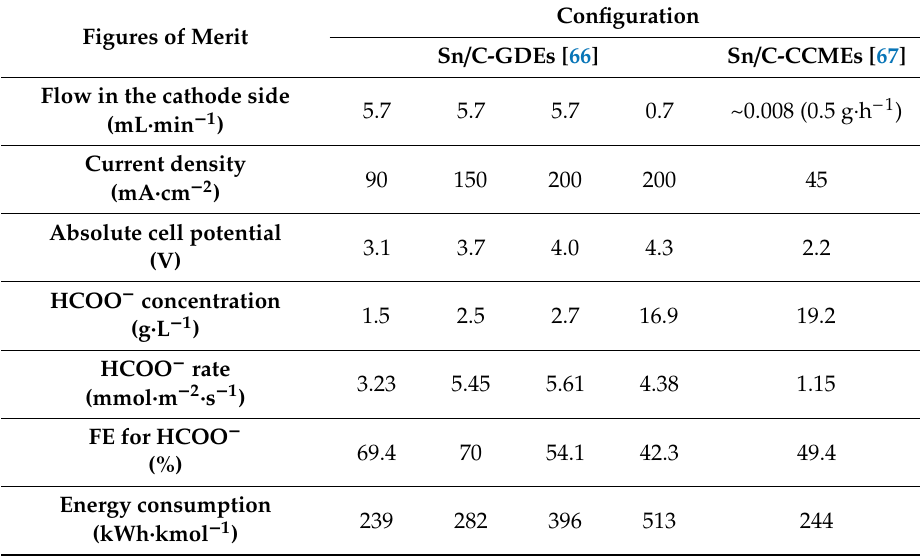
Table 1. Figures of merit (current density, flow in the cathode side, HCOO − concentration, HCOO − rate, Faradaice ffi ciency(FE)forHCOO − andenergyconsumptionperkmolofHCOO − )fortheelectrocatalytic reduction of CO 2 to HCOO − employing di ff erent Sn-based electrodes (Sn / C-GDEs and Sn / C-CCMEs). Data taken from references